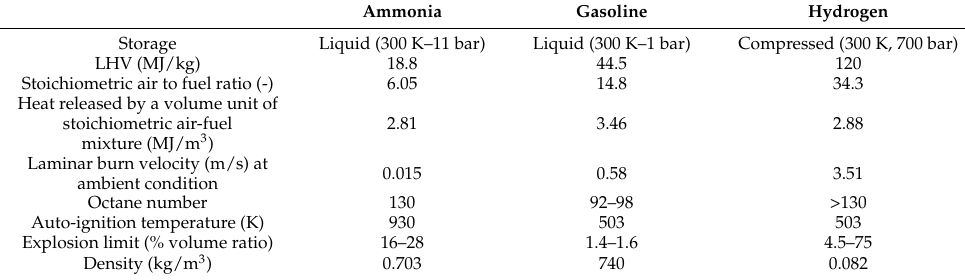
Table 1. Ammonia properties vs. gasoline and hydrogen properties